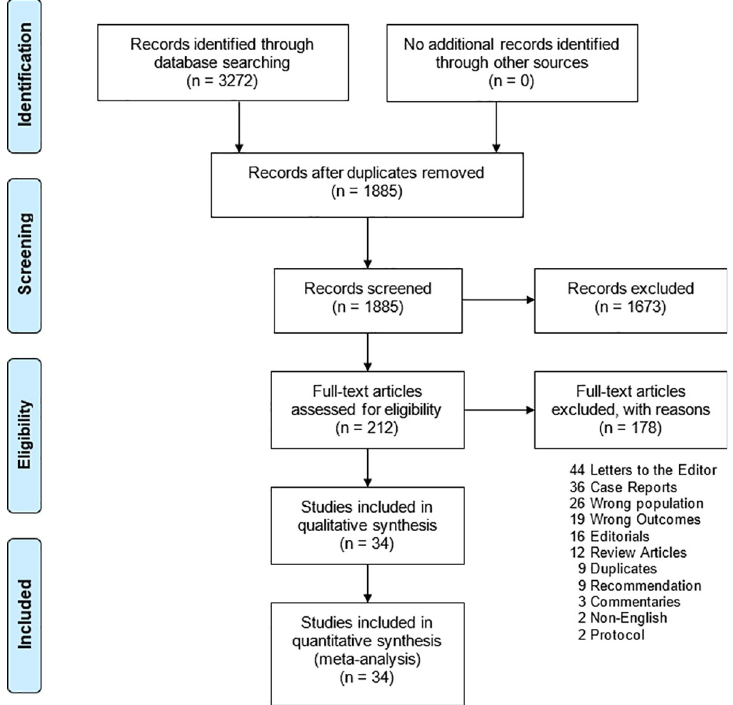
Fig 1. Preferred Reporting Items for Systematic Reviews and Meta-Analyses flowchart of study selection and database search.